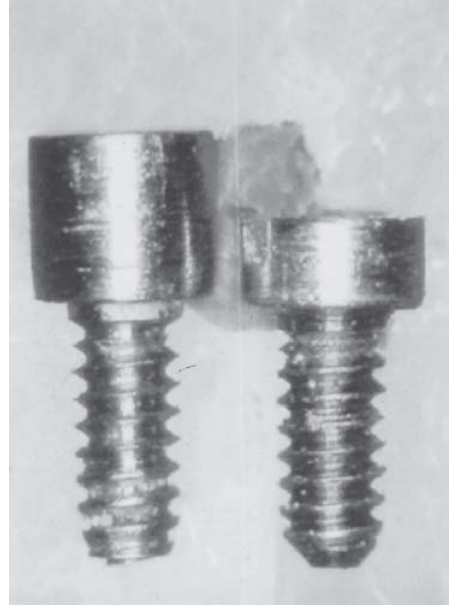
FIGURE 2- Titanium and gold screw general